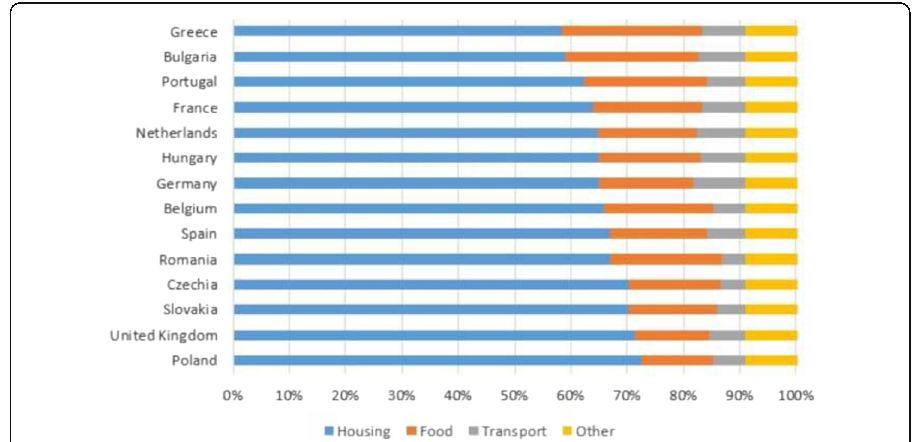
Fig. 3 Relative share of individual items in the lower threshold of LW. Source: own calculation based on WI from December